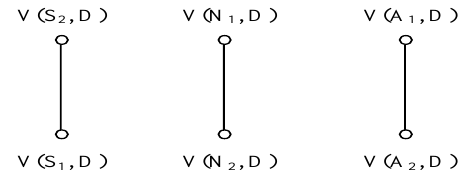
Fig. 4. Total order amongst arguments.